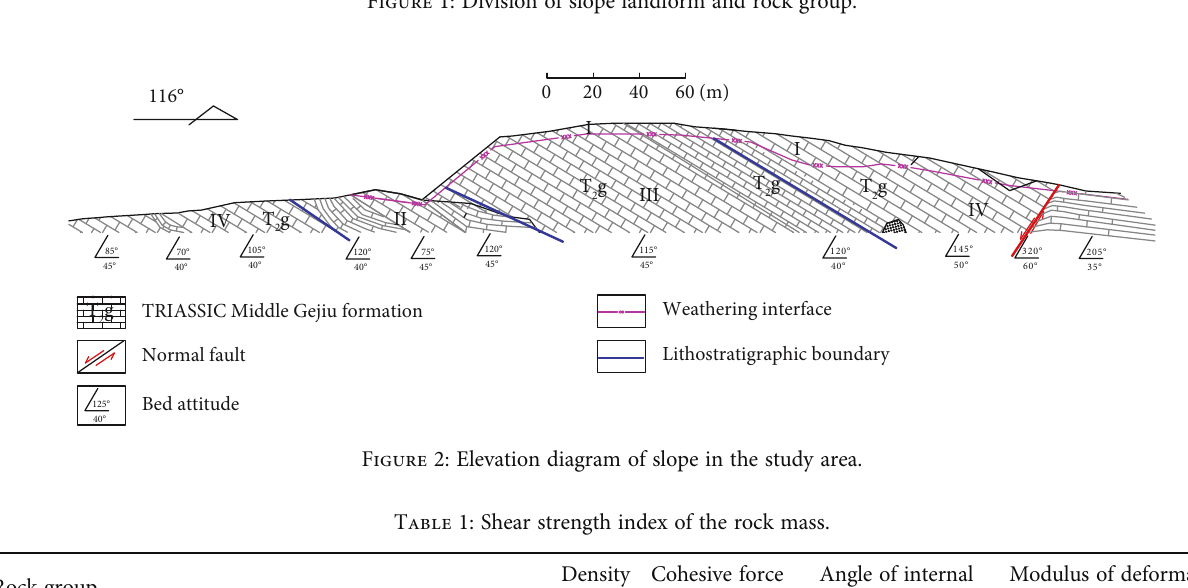
Figure 1: Division of slope landform and rock group.